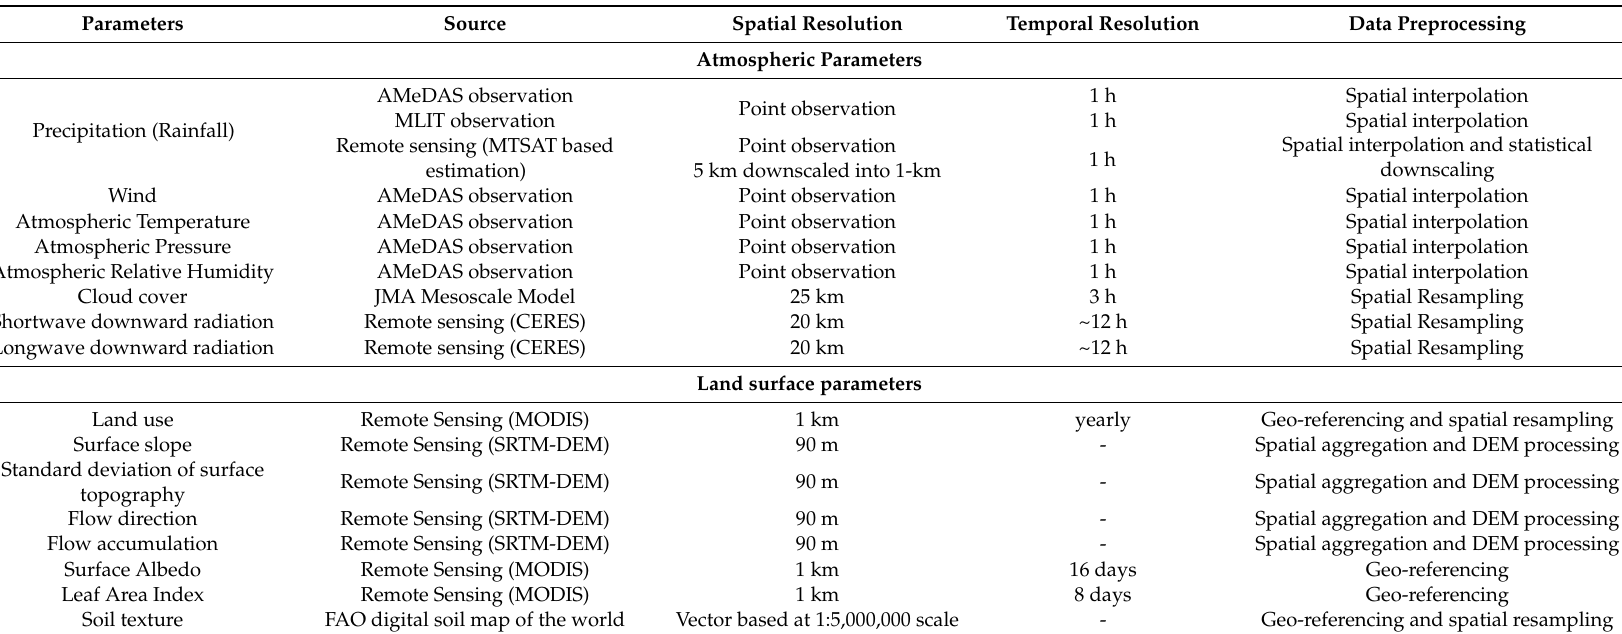
Table 1. Atmospheric and land surface parameters sources and preprocessing. AMeDAS, Automated Meteorological Data Acquisition System; MLIT, Ministry of Land, Infrastructure and Transportation; MTSAT, Multi-purpose Transport Satellite; MODIS, Moderate Resolution Imaging Spectroradiometer; SRTM-DEM, Shuttle Radar Topographic Mission Digital Elevation Model; CERES, Cloud and Earth’s Radiant Energy